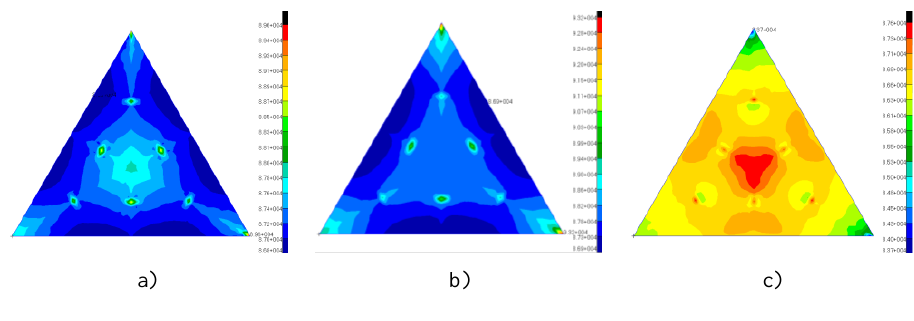
Fig. 21. Stressed state of the knitted mesh fabric in Pa: a) equivalent stresses 𝜎 𝑒 distribution, b) principal stress 𝜎 1 distribution, c) principal stress 𝜎 2